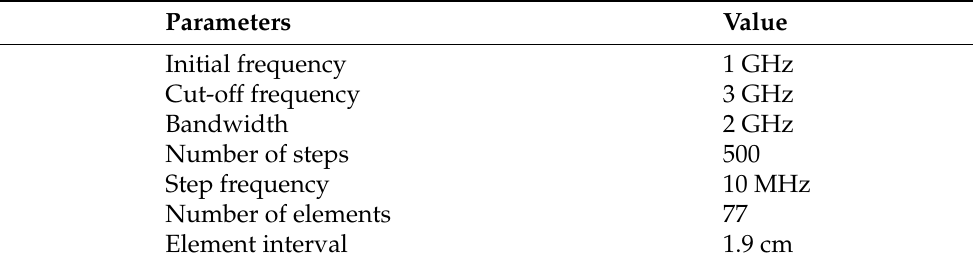
Table 2. Simulation